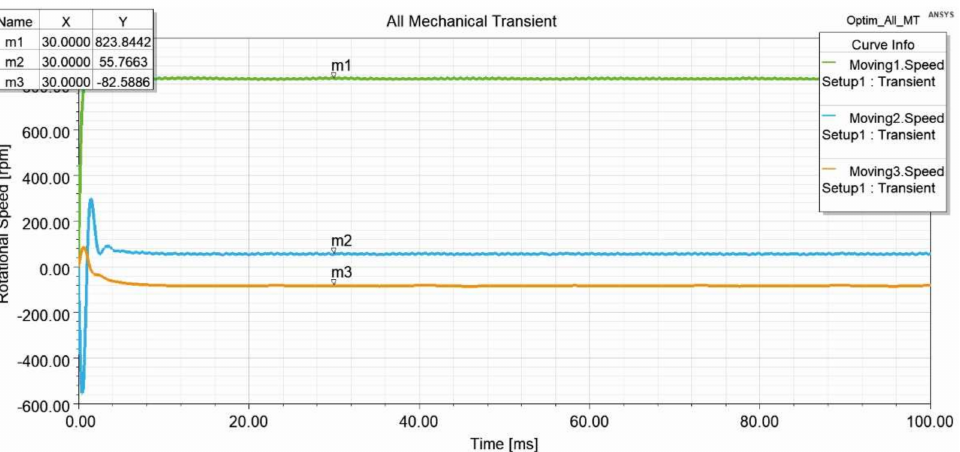
Figure 12. Rotational speed when all the motions are set to consider the mechanical transient.